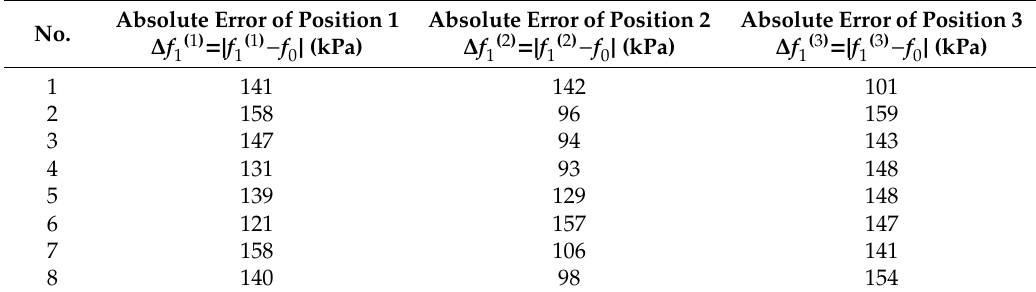
Table 6. Measurement absolute errors by the conventional method.